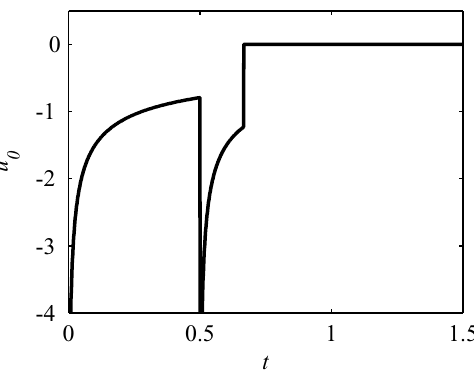
Fig. 2. Optimal control for ∆ = 1 .